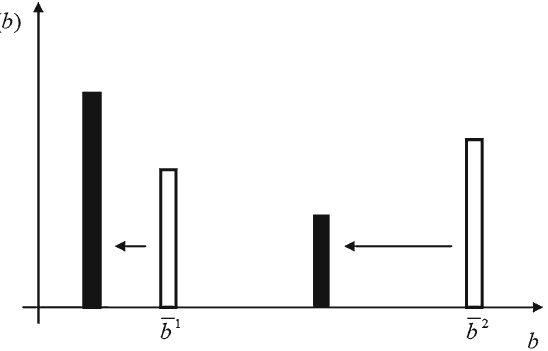
Fig. 5 The effect on the distribution of bequests of a marginal rise in the inheritance tax. (Source: Alonso- Carrera et al.